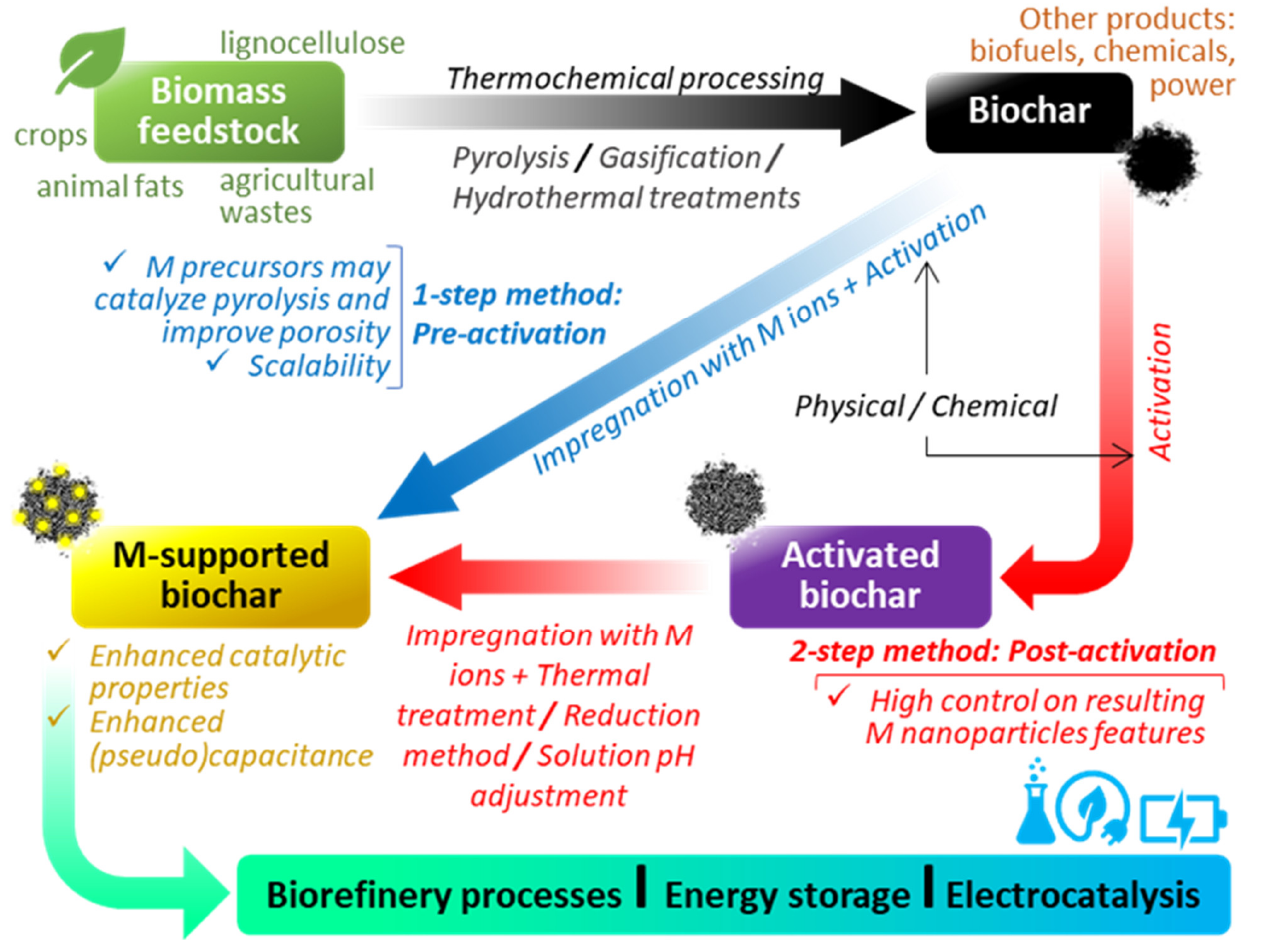
Figure 2. Schematic diagram of: one-step and two-step methodologies to metal-supported biochar synthesis, properties enhancement, and the advantages to the applications proposed in this review.